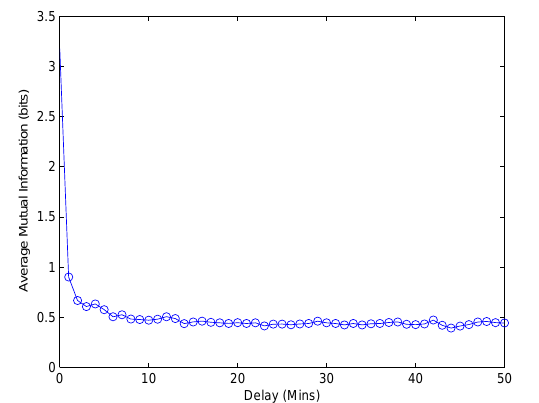
Figure 3. Average mutual information against time delay for TEC measured at Yola.